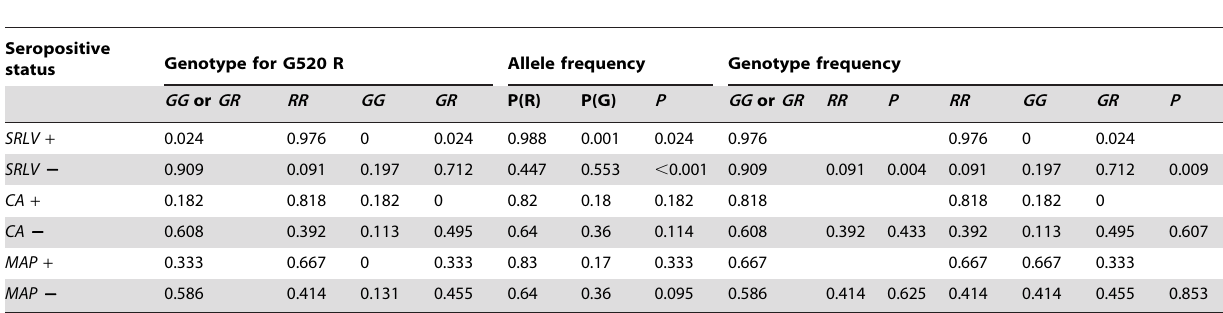
Table 5. Genotype frequency of the G520R substitution in sheeps seropositive or seronegative for Small Ruminant